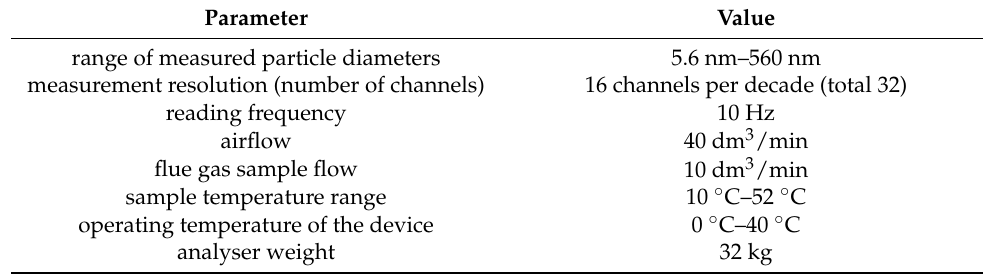
Table 4. Spectrometer characteristics of EEPS TSI